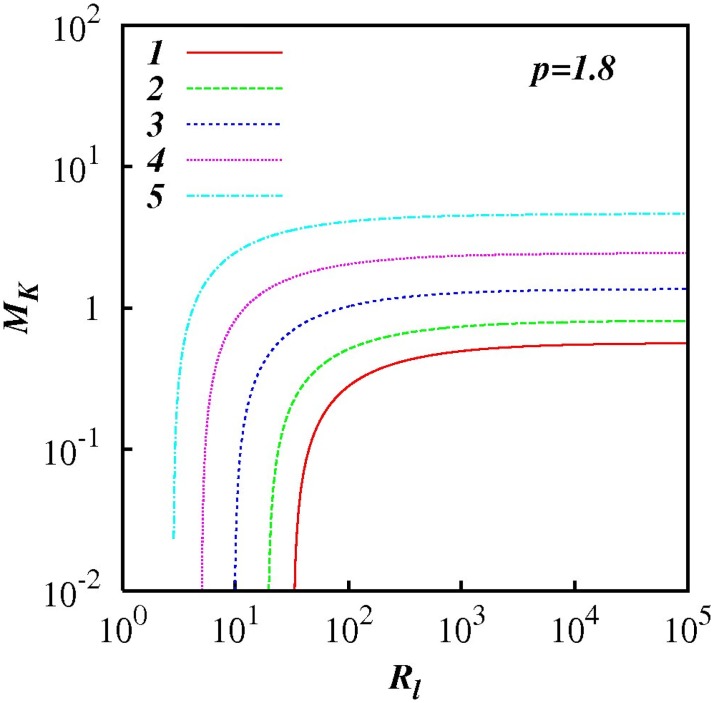
Similar to Fig 7, except for p = 1.8.